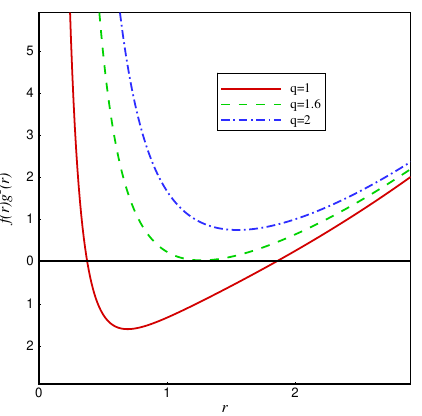
Figure 5 . The behavior of B ( r ) = f ( r ) g 2 ( r ) for charged rotating black string given in eq. (4.3) with di(cid:11)erent q . Here we have taken m = 2, b = 3 and (cid:3) = 1.